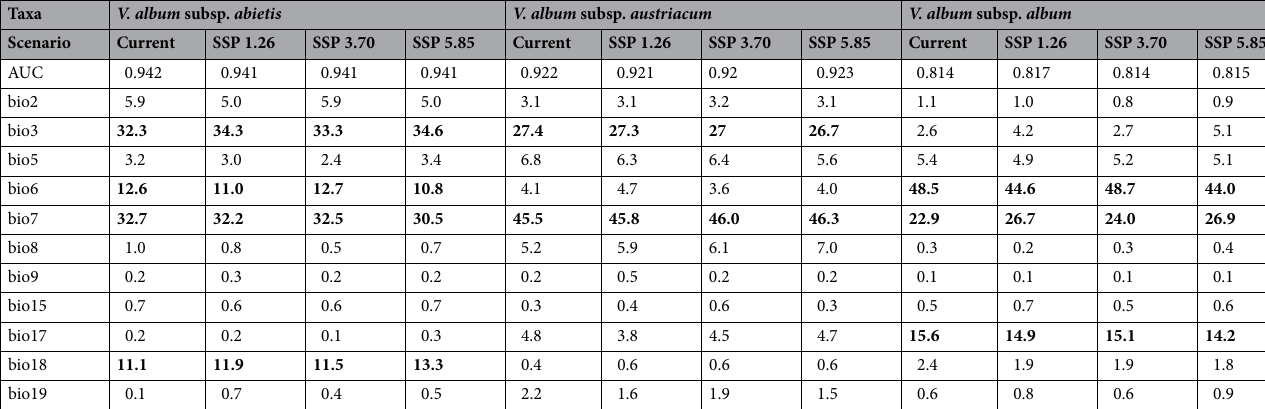
Table 1. Contribution (%) of the most important bioclimatic variables in the tested climate models. AUC area under the curve, variables presented in the table are as follows: bio2 (Mean Diurnal Range of Temperature), bio3 (Isothermality), bio5 (Maximum Temperature of Warmest Month), bio6 (Minimum Temperature of Coldest Month), bio7 (Temperature Annual Range), bio8 (Mean Temperature of Wettest Quarter), bio9 (Mean Temperature of Driest Quarter), bio15 (Precipitation Seasonality), bio17 (Precipitation of Driest Quarter), bio18 (Precipitation of Warmest Quarter), and bio19 (Precipitation of Coldest Quarter). The most important variables are bolded.